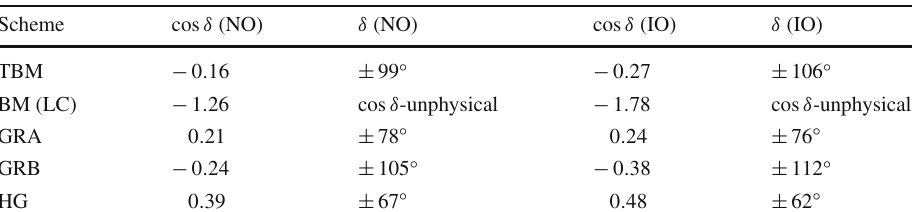
Table 3 Predicted values of cos δ and δ for the five symmetry forms, TBM, BM, GRA, GRB and HG, and ˜ U e given by the form A0 in Eq. (67), obtained using Eq. (69) and the best fit values of sin 2 θ 12 , sin 2 θ 23 and sin 2 θ 13 for NO and IO neutrino mass spectra from Ref. [54] (From Refs. [39,41].)